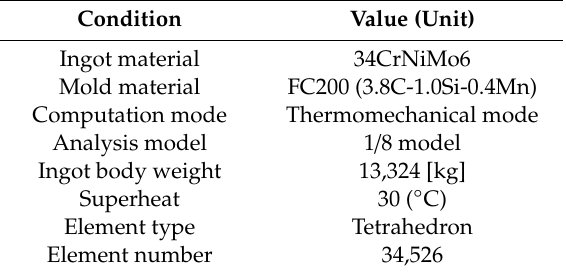
Table 2. Simulation conditions for ingot